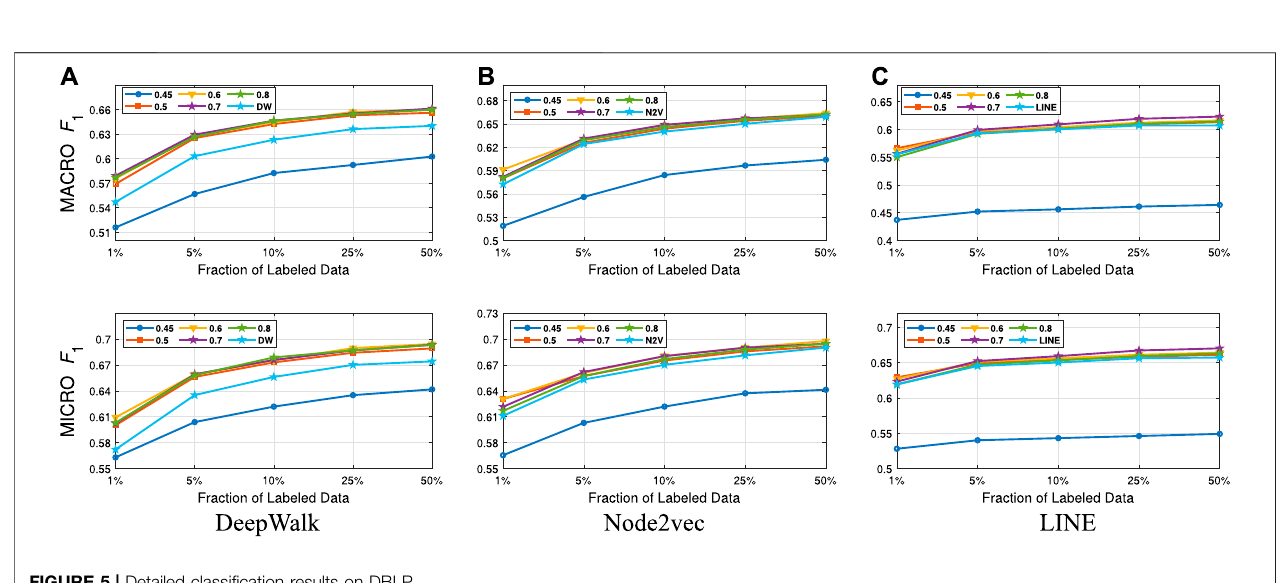
FIGURE 5 | Detailed classi fi cation results on